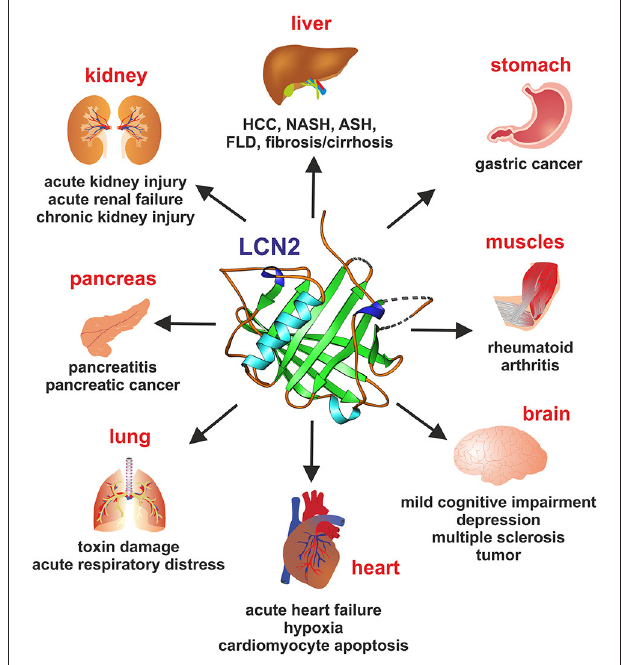
FIGURE 2 | Lipocalin 2 (LCN2) in organ damage. Representative pathophysiological or malignancies conditions for which elevated LCN2 concentrations in representative organs are indicative are